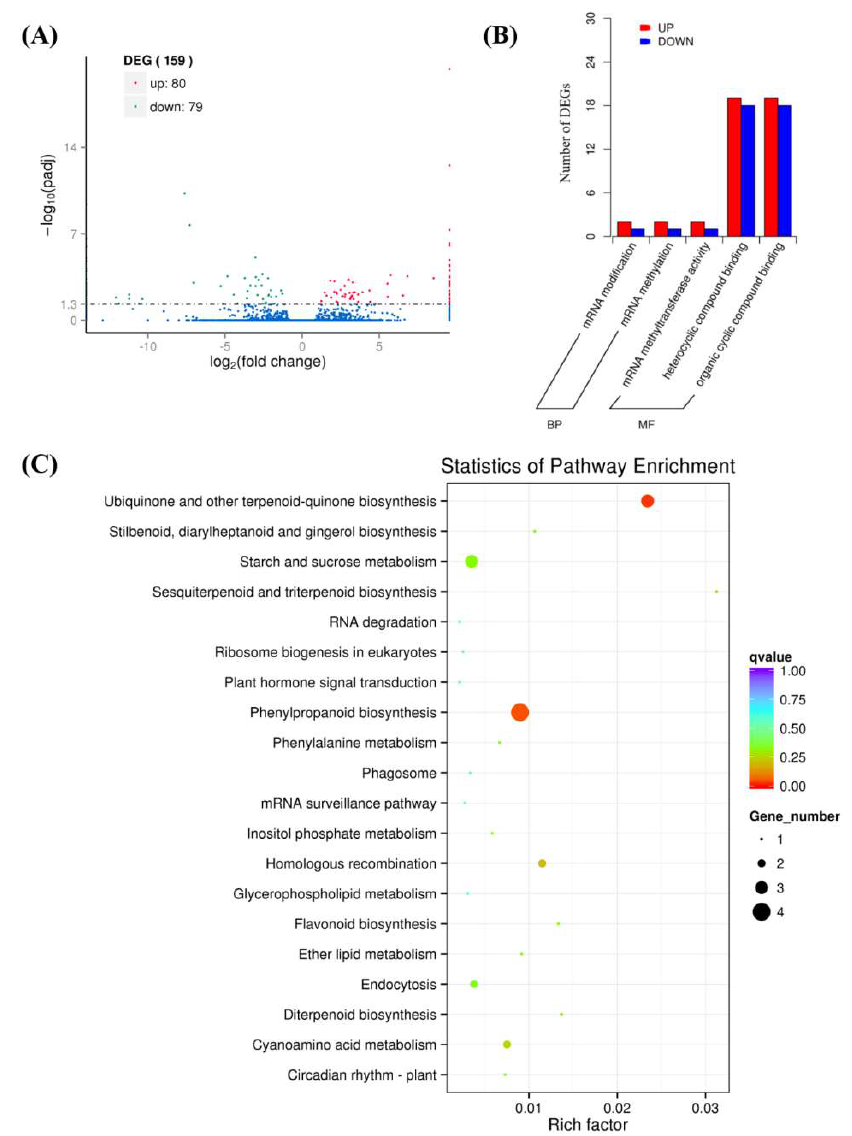
Figure 4. DEGs annotation and enrichment in response to GA 3 treatment. ( A ) Distribution of the DEGs at 2 days after GA 3 treatment. The selected level of DEGs was | log2(Fold Change) | > 1. ( B ) GO (Gene Ontology) enrichment of DEGs from GA 3 treatment versus control. BP: biology process. MF: molecular function. ( C ) KEGG (Kyoto Encyclopedia of Genes and Genomes) enrichment of DEGs from GA 3 treatment versus control.